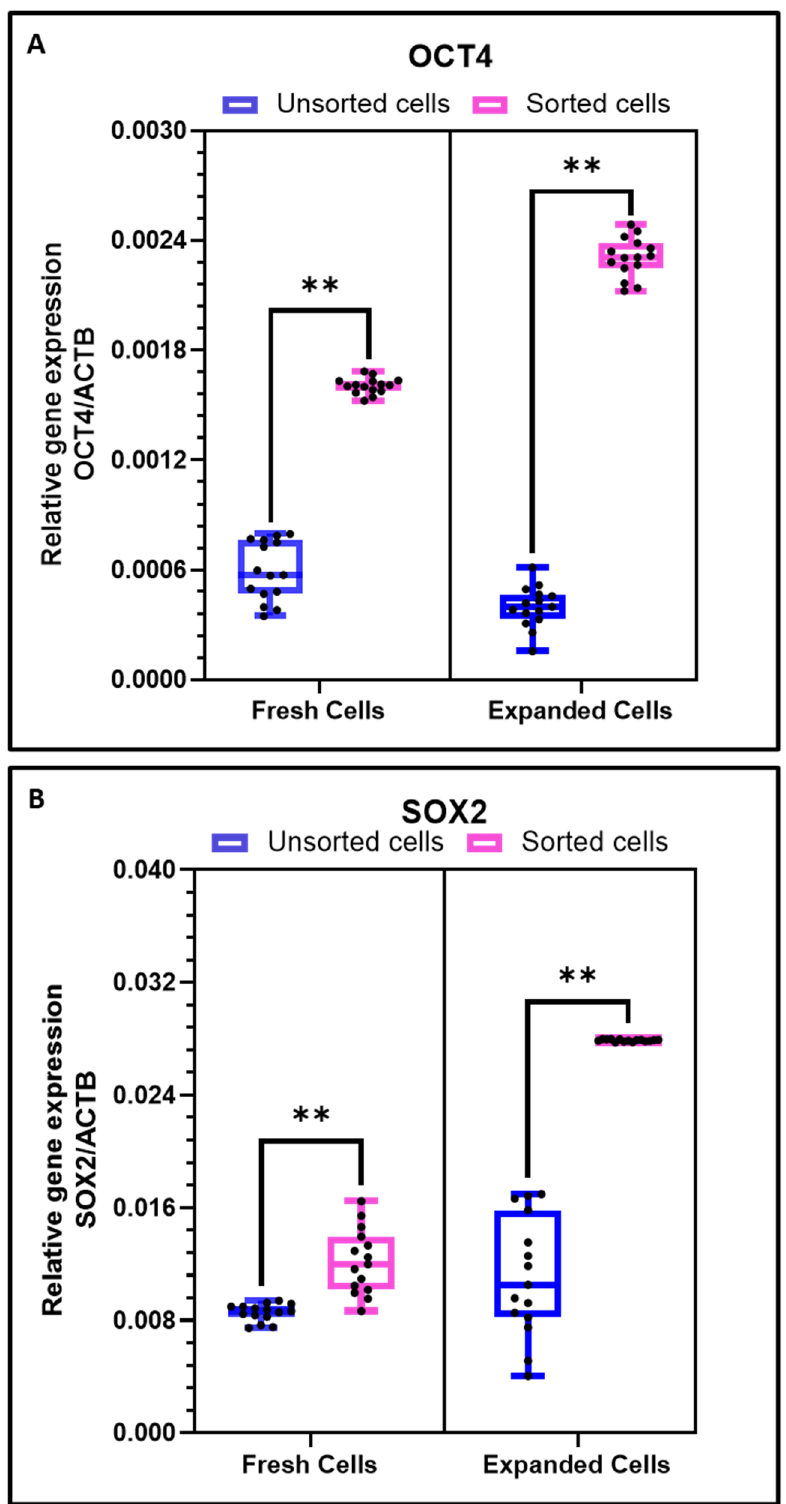
Figure 3. Comparative gene expression analysis of freshly isolated cells and culture expanded cells. ( A ) Comparative gene expression analysis of stemness gene OCT4 in OSCC cells and sorted CD44+ cells; ( B ) Comparative gene expression analysis of stemness gene SOX2 in OSCC cells and sorted CD44+ cells. Experiments were performed in triplicates for all five samples independently. ns not significant, ** p < 0.01 .